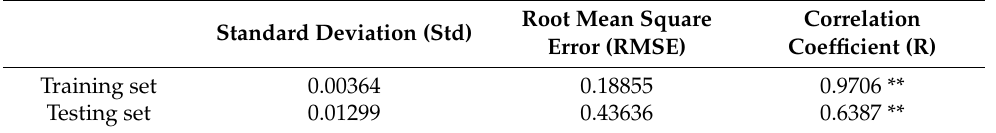
Root Mean Square Correlation Error (RMSE) Coefficient (R)